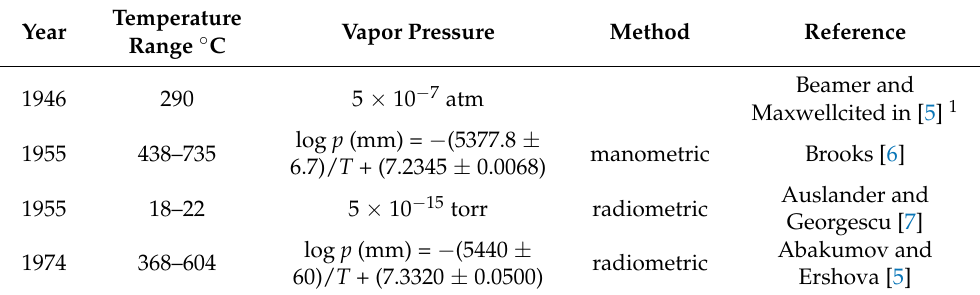
Table 1. Overview of experimental results of the vapor pressure of pure metallic polonium.